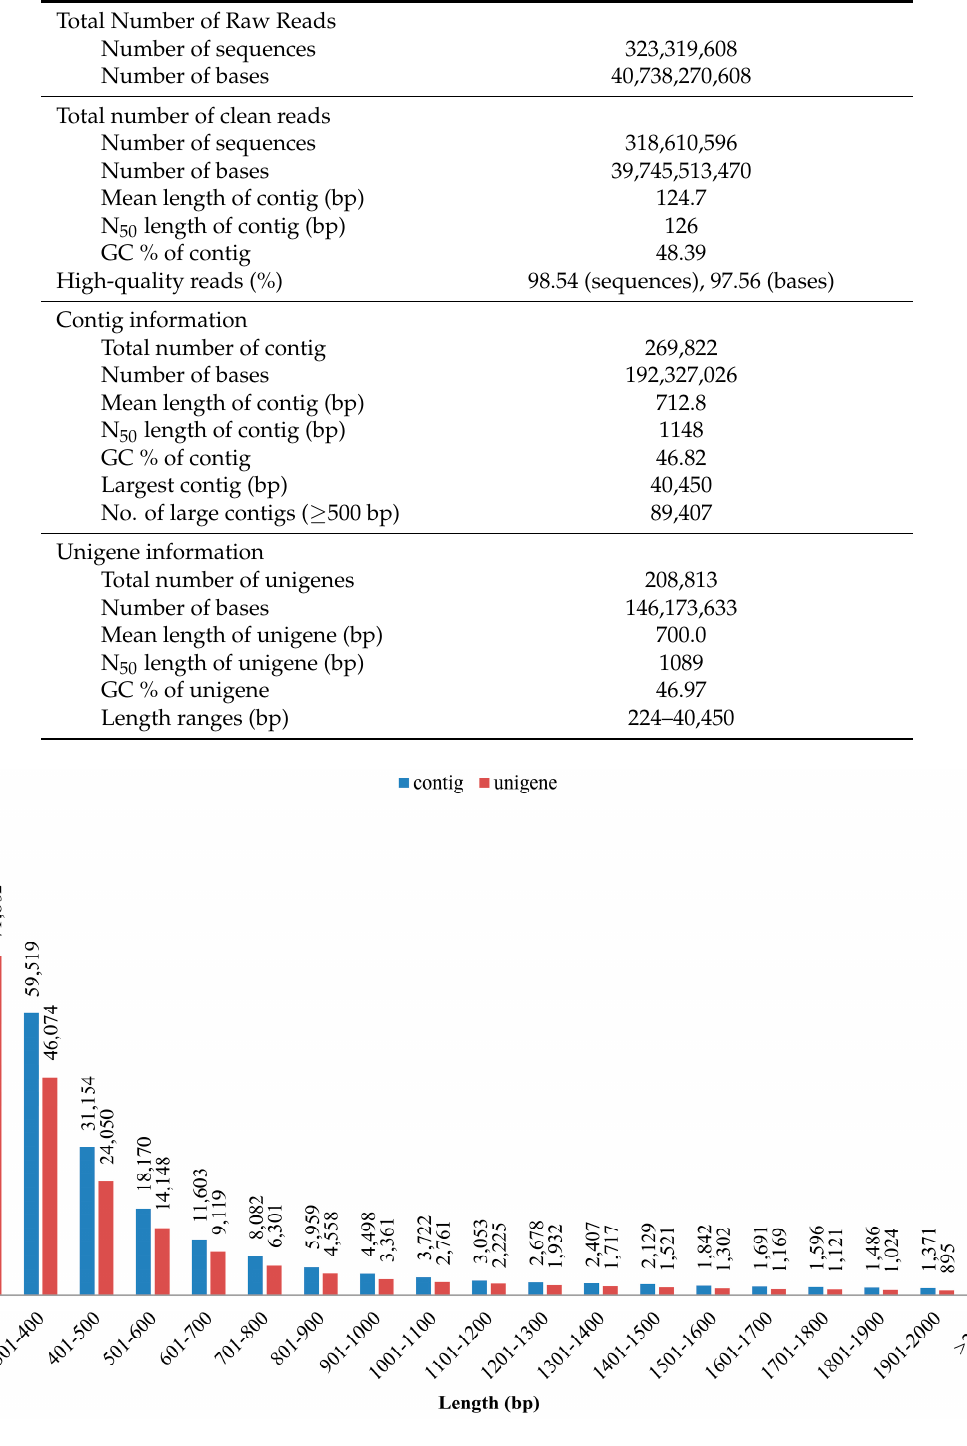
Table 1. Summary statistics from Illumina sequencing of the T. longicaudatus .